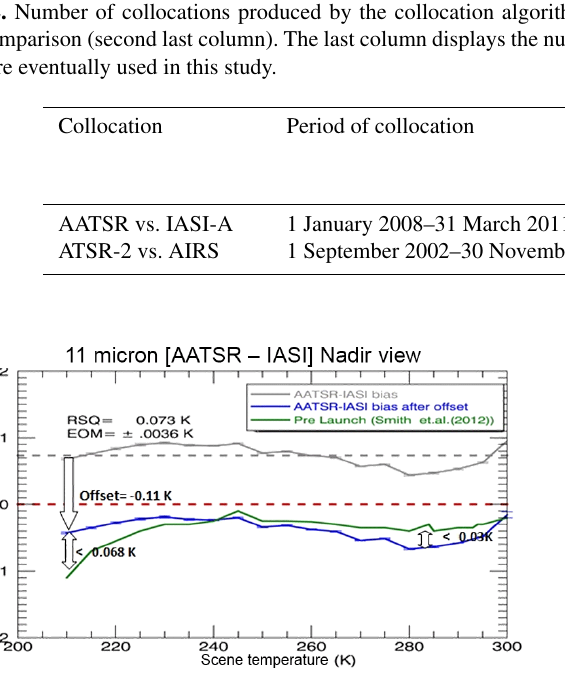
Figure 3. Temperature dependence of AATSR–IASI-A (in grey) bias over the period of 39 months. Blue curve is the same tem- perature dependence with an offset of 0.11K (i.e. post launch) sub- tracted from it. This blue curve is similar to pre-launch (Smith et al., 2012) characteristics of AATSR to within hundredth of a